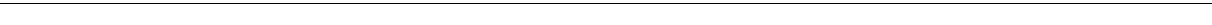
Figure 6 | Interaction between Cep295 and Cep192 is required for centriolar localization of Cep192. ( a ) Schematic of full-length Cep192 and the deletion mutants used for co-IP assays with endogenous Cep295 in U2OS cells. The minimal Cep295-binging region in Cep192 is represented in grey. ( b ) U2OS cells were transfected with Flag-Cep192 full-length and the indicated mutants. The cells were stained with antibodies against Cep192 (green) and CP110 (red). Scale bar, 1 m m. ( c , d ) U2OS cells expressing Flag-Cep192 full length or the deletion mutant proteins were immunoprecipitated with FLAG beads. Total cell lysates and IPs were analysed by western blotting using Cep295, Flag or tubulin antibodies. ( e ) GSTpull-down assay showing the interaction between Cep295 and Cep192 fragments (aa 1727–2204 of Cep295 and aa 1501–2040 of Cep192) in vitro. These bacterially purified recombinant proteins contain the interacting regions that were identified by co-immunoprecipitation experiments. ( f , g ) For rescue experiments, Cep192-depleted U2OS cells were transfected with RNAi-resistant full-length Cep295 and the indicated mutant. Scale bar, 5 m m. Histograms represent frequency of bipolar mitotic spindles with the indicated number of g -tubulin foci. Values are mean percentages ± s.e.m from three independent experiments ( N ¼ 30 for each condition). * P o 0.05 (two-tailed t -test). ( h , i ) Dominant negative effects of the Cep192 fragment that binds to Cep295. U2OS cells were transfected with full-length Cep295 and the indicated mutant. Scale bar, 1 m m. Histograms represent frequency of transfected cells with the indicated intensity of g -tubulin foci. Values are mean percentages ± s.e.m from three independent experiments ( N ¼ 30 for each condition). ** P o 0.01 (two-tailed t